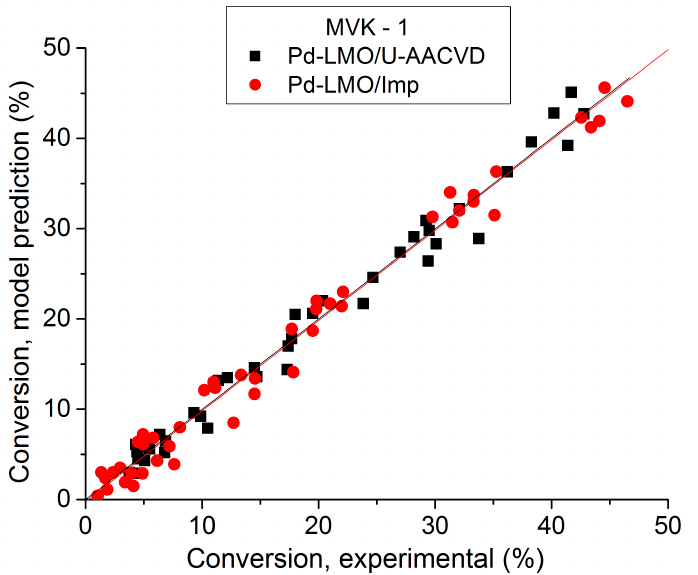
Figure 8. Comparison between the experimentally measured conversions and the predicted by MVK-1 model.